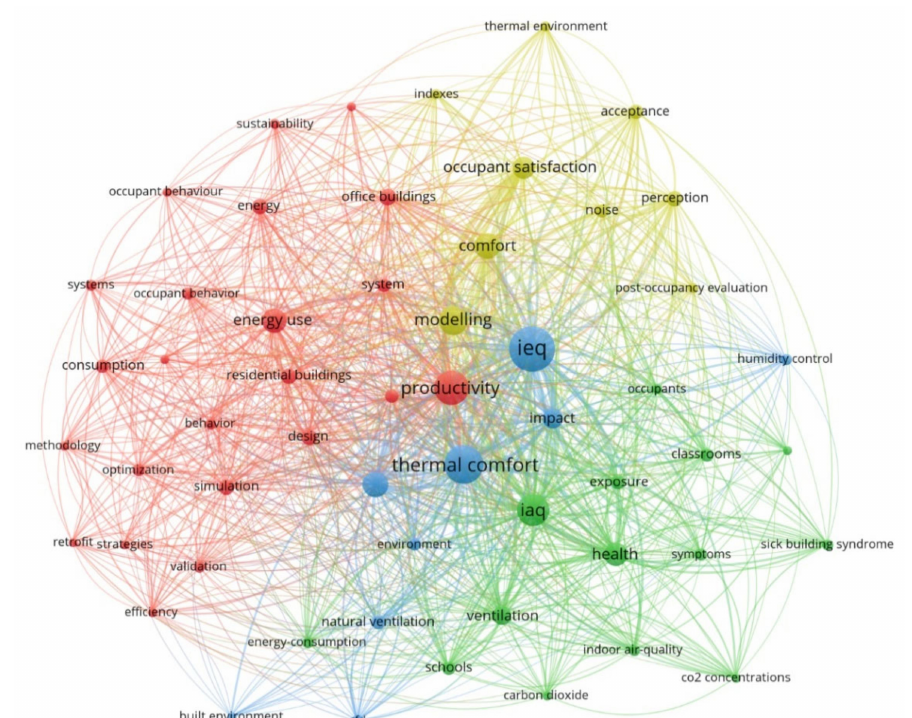
Figure 5. High-frequency keywords